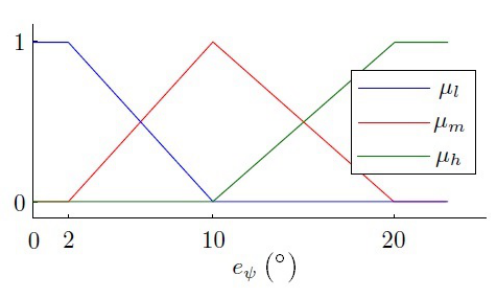
Figure 18. Yaw error fuzzy set. Membership functions µ l , µ m and µ h